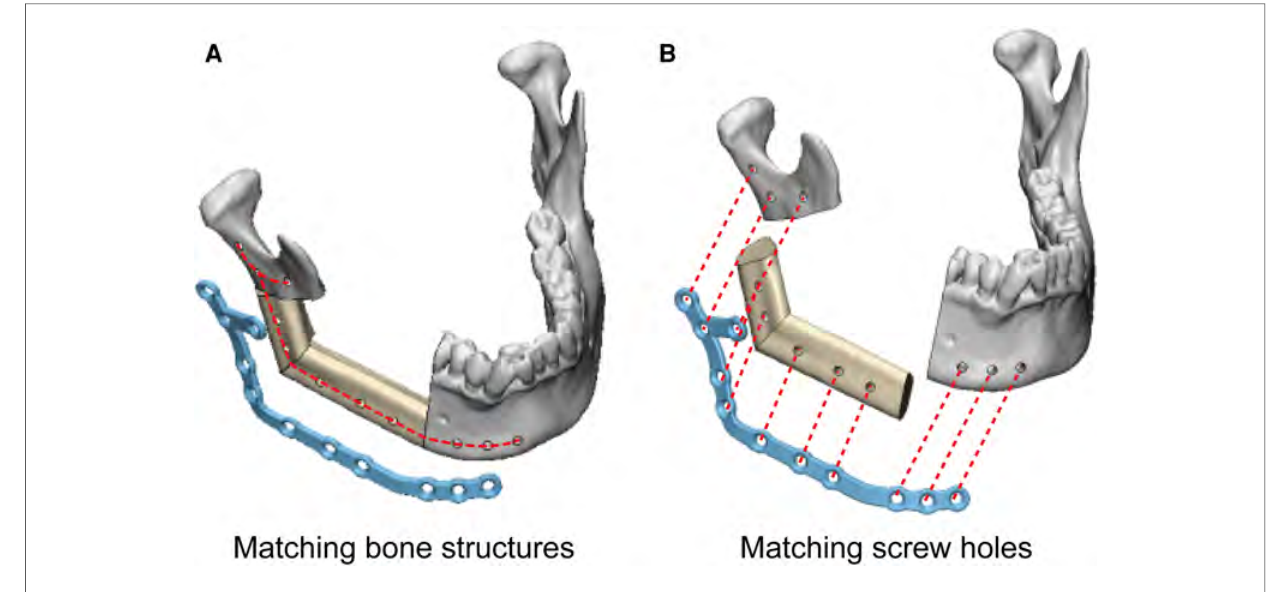
FIGURE 4 The art of matching structures (A) and holes (B) in PSSPs-enhanced CAMR.